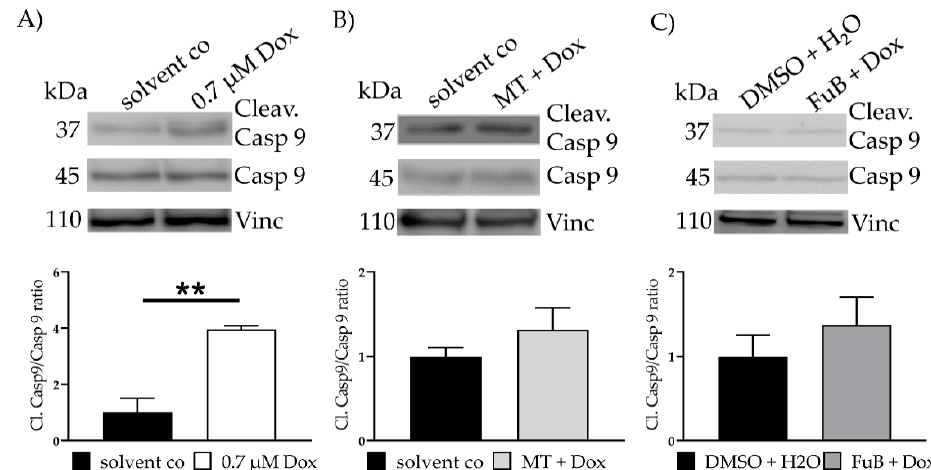
Figure 4. Apoptosis induction measured with WB ( A ) Cells were treated with Dox for 24 h. Cleav.Casp9/Casp9 ratio was detected with WB. Shown is one representative blot. ( B ) Cells were pre-treated with MT followed by Dox for 24 h. Cleav.Casp9/Casp9 ratio was detected with WB. Shown is one representative blot. ( C ) Cells were pre-treated with FuB followed Dox for 24 h. Cleav.Casp9/Casp9 ratio was detected with WB. Shown is one representative blot. Depicted are mean values and standard deviation of minimum three biological replicates. Significances were calculated with a t -test. ** = significant to solvent co. (** p ≤ 0.01).